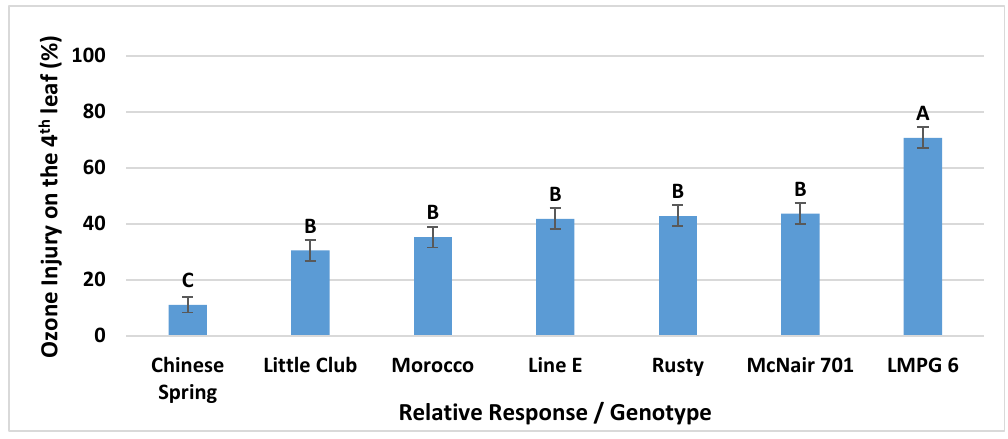
Figure 4. The overall average (±SE) O 3 injury on the fourth leaf of rust near-universal susceptible genotypes, after exposure to four different O 3 levels (50, 70, 90, 110 ppb), for 5 days (7 h/day), at 25 °C and 60% RH, in continuous stirred tank reactors (CSTRs). Injury were visually estimated two days after the end of exposure, under constant light conditions according to a 0 – 100% scale. Means were statistically separated using Tukey-Kramer adjustment for multiple comparisons. Means marked with the same letter are not significantly different at α = 0 .05.